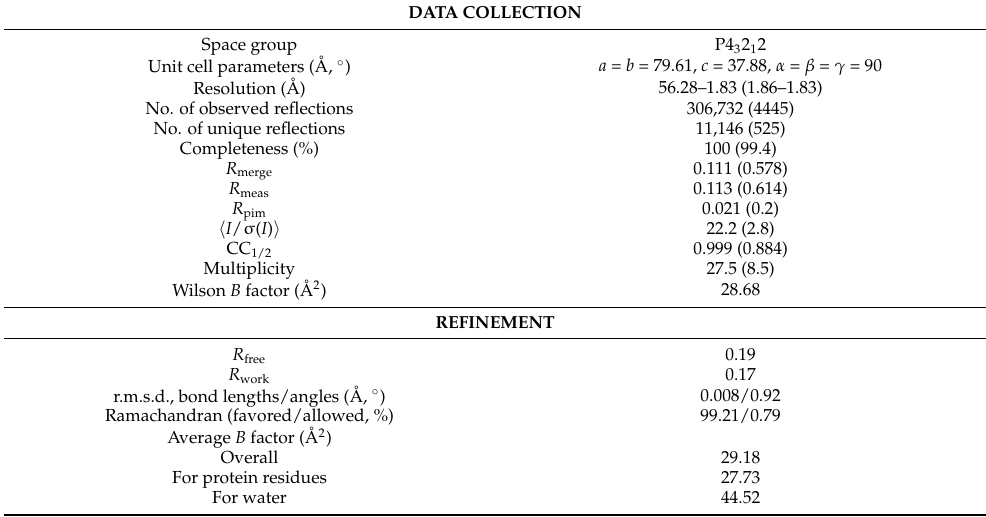
Table 1. Data and refinement statistics. Values in parentheses correspond to the highest resolution shell.